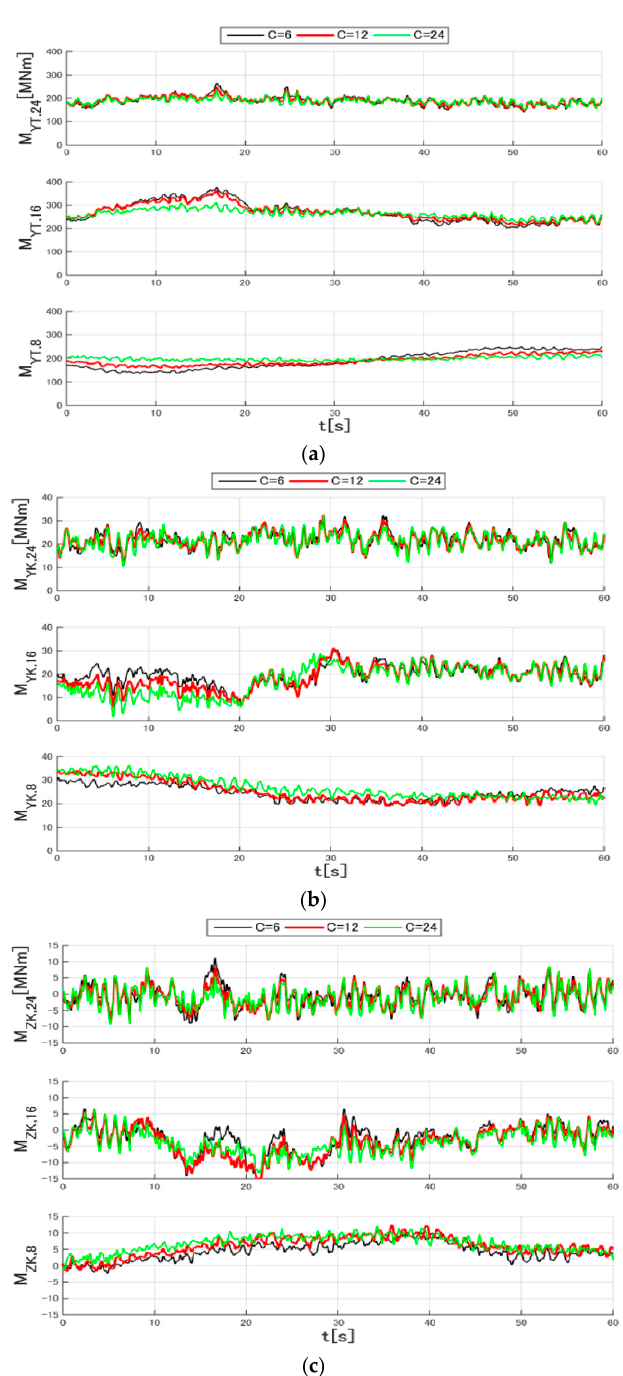
Figure 12. Time history of tower loads (24 m/s, 16 m/s and 8 m/s at the centre hub, 0–60 s): ( a ) tower base fore ‐ aft bending moment; ( b ) tower top nodding moment; and ( c ) tower top yawing moment.